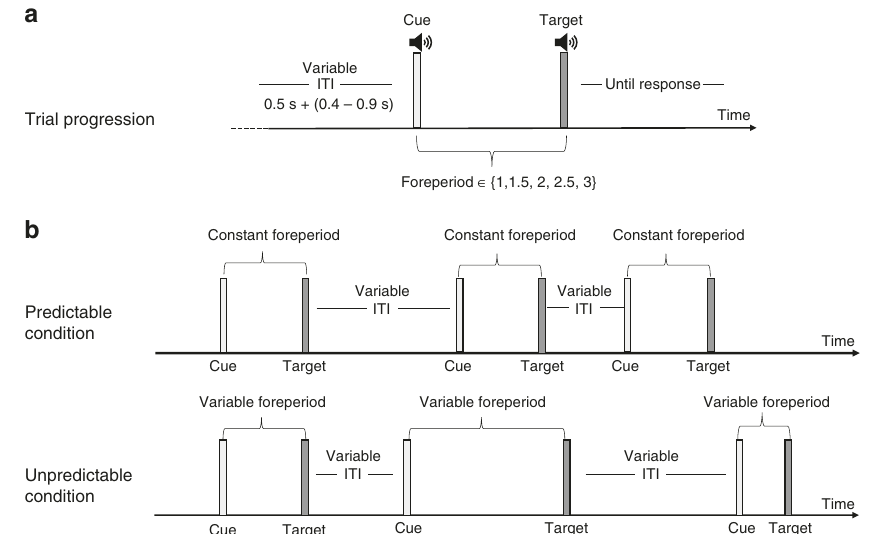
Fig. 1 Experimental procedure of Experiment 1. a After an online gaze contingent procedure con fi rmed fi xation (<0.5° off center) and following an additional random inter-trial-interval (ITI; 0.4 – 0.9 s), the temporal cue (pure tone of 5 KHz) was played for 33 ms, marking the onset of the foreperiod (1/1.5/2/2.5/3 s). After the foreperiod, the target tone (descending or ascending chirp sound) was played for 33 ms and participants were asked to perform a 2-alternative forced choice (2AFC) discrimination task: report whether the chirp was ascending or descending by pressing one of two buttons. Participants were instructed to be as accurate as possible and to respond within the 4 seconds response window. Following the response, or after 4 s without one, the fi xation cross changed color to gray for 200 ms to signal the end of the trial. b The foreperiod was either constant throughout the block (predictable condition) or changed randomly in different trials within the same block (unpredictable condition). Thus, the cue acted as a 100% valid temporal cue in the predictable condition but was uninformative regarding target timing in the unpredictable condition. The stimuli were identical in the two conditions, and differed only in the validity of the temporal cue in predicting the time of the target. Participants were not informed as to any predictability; therefore, all temporal expectations were learned